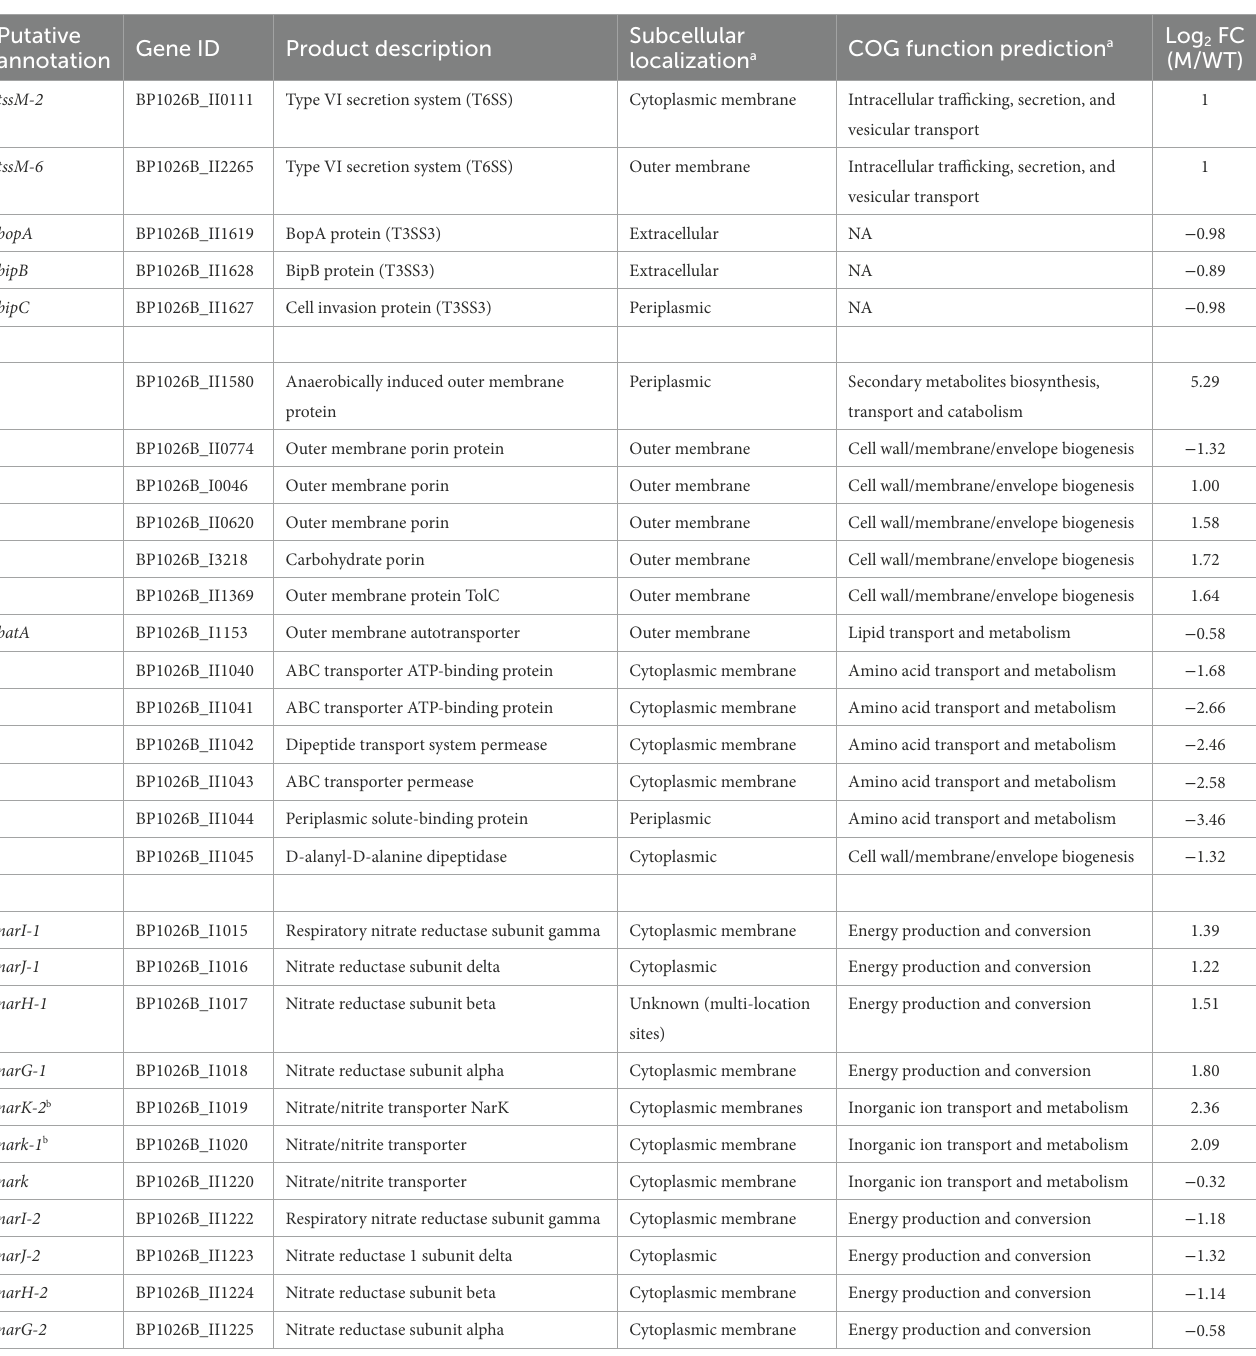
TABLE 2 Genes regulated by SapR encoding products closely associated with cell